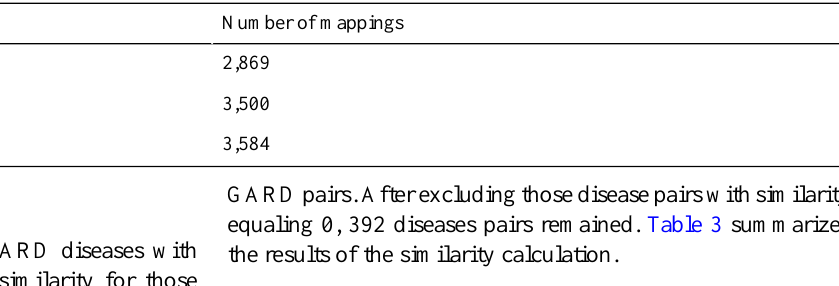
Table 2. Results of disease mapping retrieval from Neo4j graph.